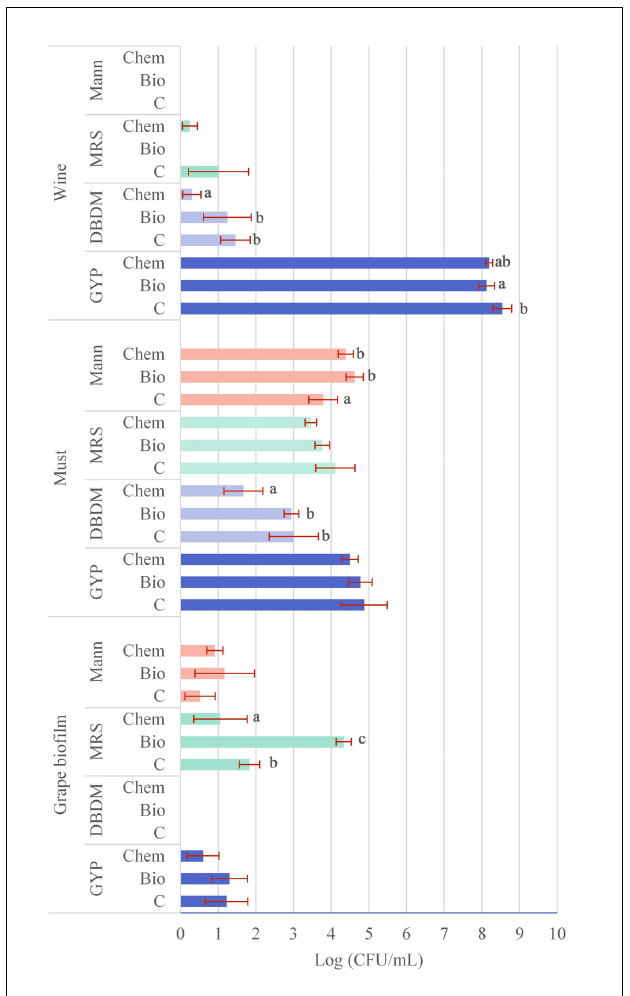
FIGURE 1 | Average viable and cultivable (VC) microbial community in log units (CFU/mL) counted on plates of different samples (C: control, Bio: bio-fungicide, and Chem: chemical fungicide) at different stages (1: grape biofilm; 2: must, 3: wine) and from different culture media (GYP, DBDM, MRS, and Mann), the statistical analysis (different letters mean significant differences p < 0.05 between treatments) and error bars. Empty bars mean no colonies